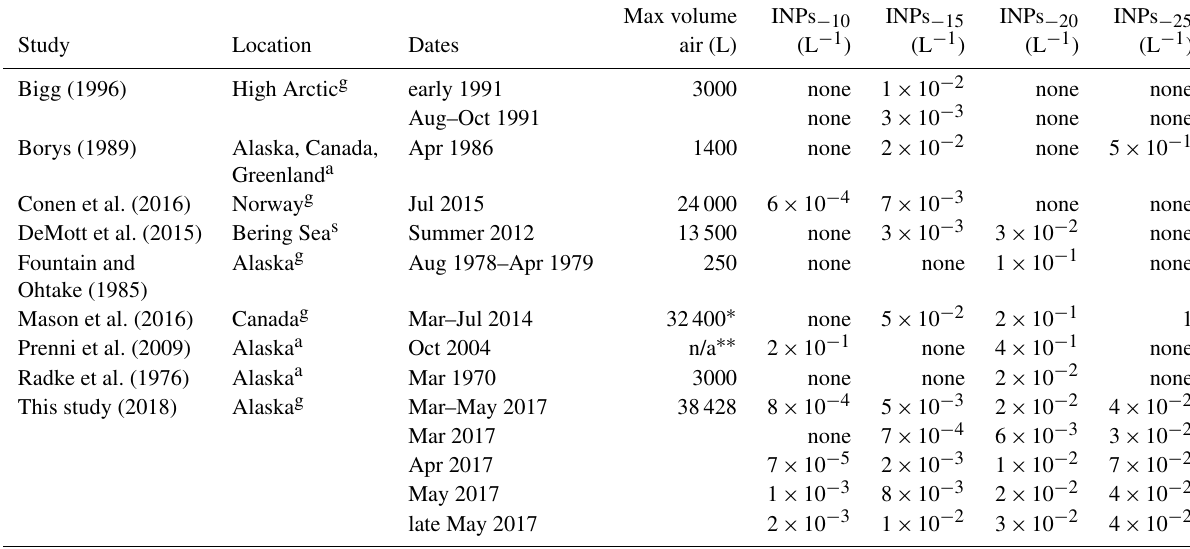
Table 2. Comparison of atmospheric immersion mode INP measurements presented here with previous studies in the Arctic. Study reference, location, dates, and average INP concentrations converted to units of per liter (L − 1 ) reported for up to the four different temperatures shown. The superscripts “g”, “s”, and “a” represent ground-based, shipborne, and airborne measurements, respectively. “None” refers to no reported concentrations (or observed, in the case of the current study) measured at that temperature. Max volume INPs − 10 INPs − 15 INPs − 20 INPs − 25 Study Location Dates